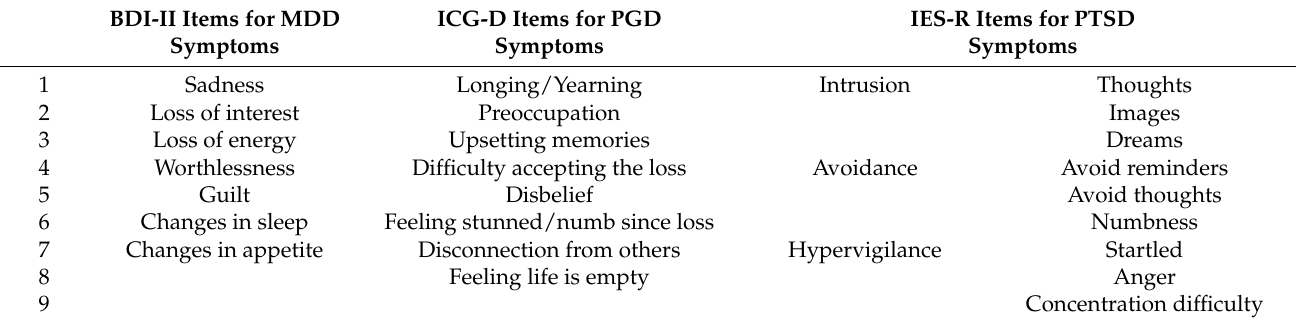
Table 1. Description of included symptoms of each